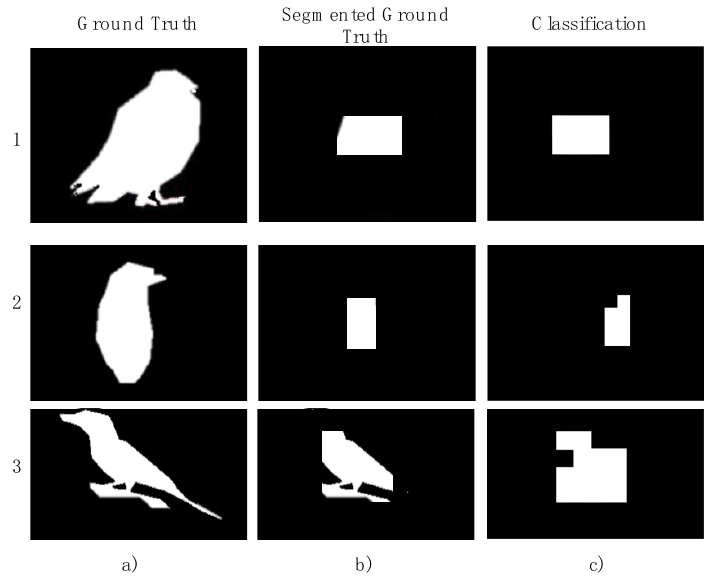
Figure 14. Comparative methodology results for three medium images. ( a ) original segmented image, ( b ) segmented image by proposed segmentation, ( c ) 15 × 15-pixel window classification. Note: the images were amplified for better illustration.